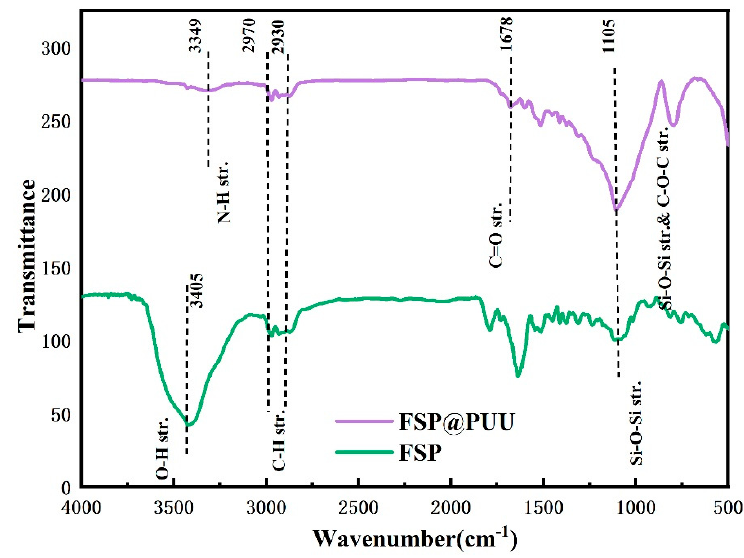
Figure 4. FTIR of FSP and FSP@PUU.